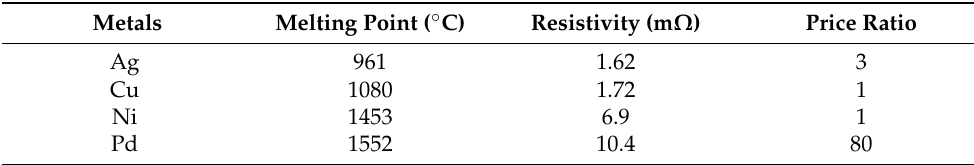
Table 2. Different electrodes’ physical characteristics and price